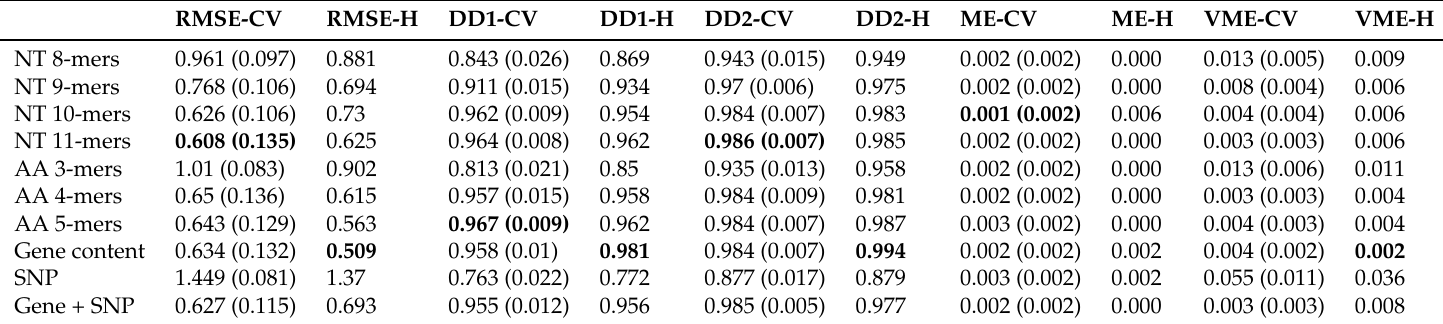
Table A50. S. enterica